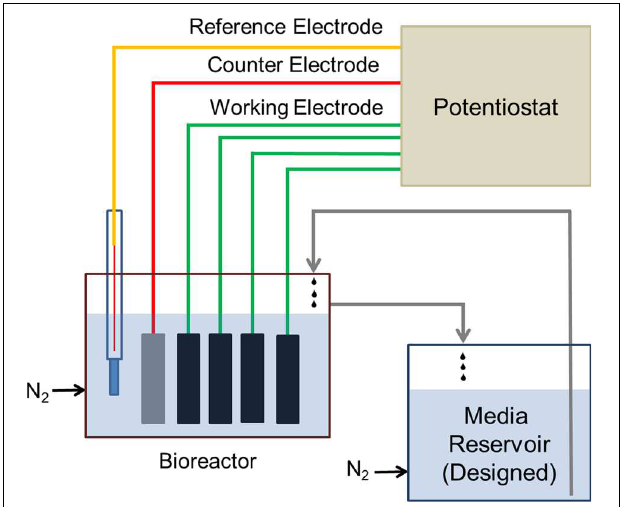
FIGURE 1 | Schematic diagram of the electrochemical enrichment reactor. The four carbon cloth working electrodes (WEs) were poised at 272, 372, 472, 572 mV vs. SHE, respectively, using a 4-channel potentiostat. The reactor and medium reservoir were continuously purged with filter-sterilized N 2 gas to maintain anaerobic